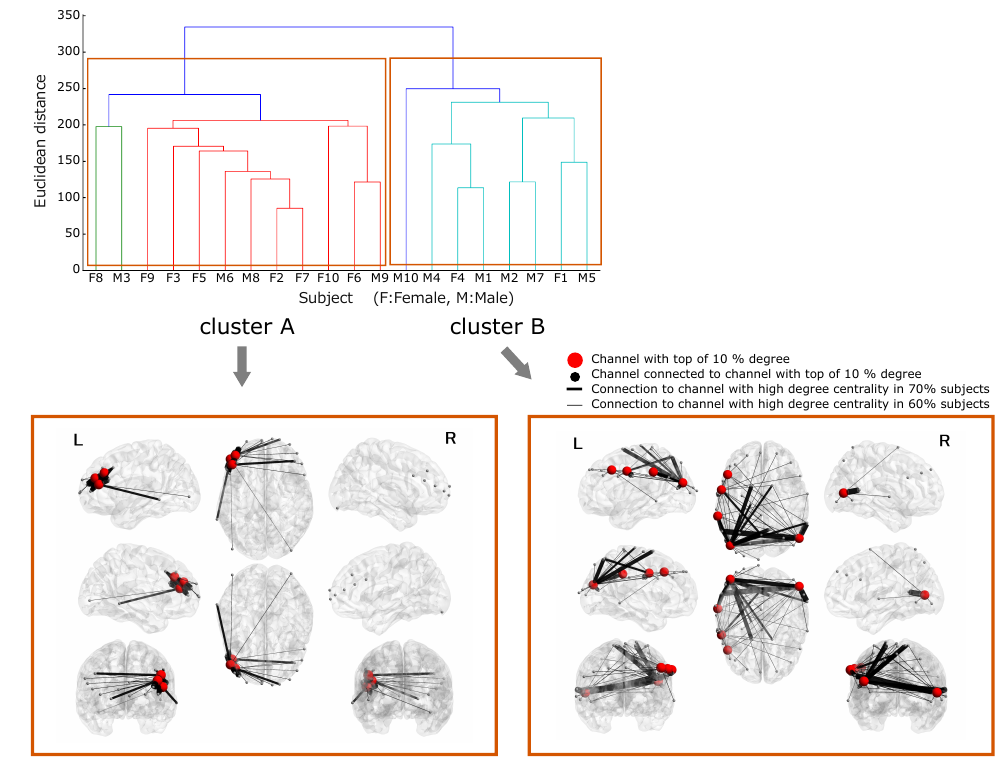
Figure 4. Brain states were classified by hierarchical clustering. Two clusters with the greatest distance were revealed. The red circle indicates the central area of the network with a high degree. Cluster A was in the frontal lobe, and Cluster B was in the temporal and lateral lobes. Letters L and R indicate the left and right sides of the brain,